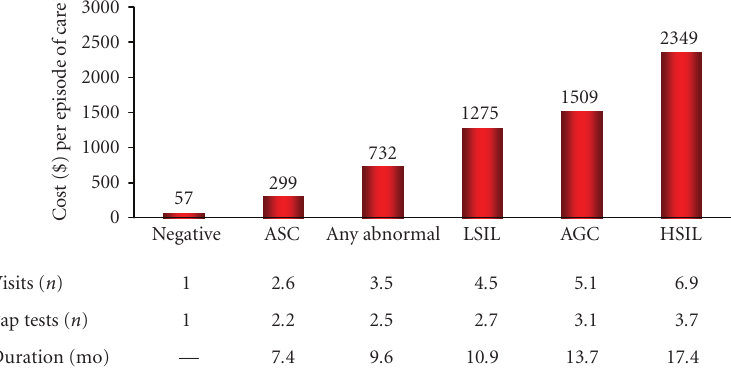
Figure 2: Average health care costs of cervical HPV infection [16]. ∗ Average age adjusted to the 1998 US female population; all cost estimates were converted to 2002 dollars; ASC = atypical squamous cells; AGC = atypical glandular cells; LSIL = low-grade squamous intraepithelial lesion; HSIL = high-grade squamous intraepithelial lesion.